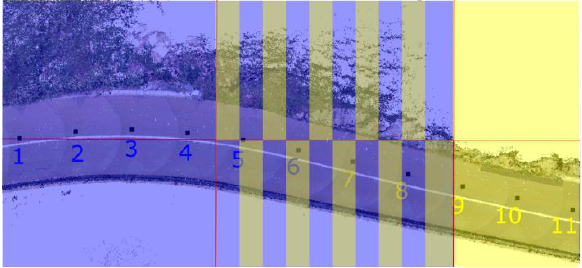
Figure 5. Sectioned trajectory points and tiles. The first section in blue. The second section in yellow. Tiles that belong to both sections are coloured in stripes of both